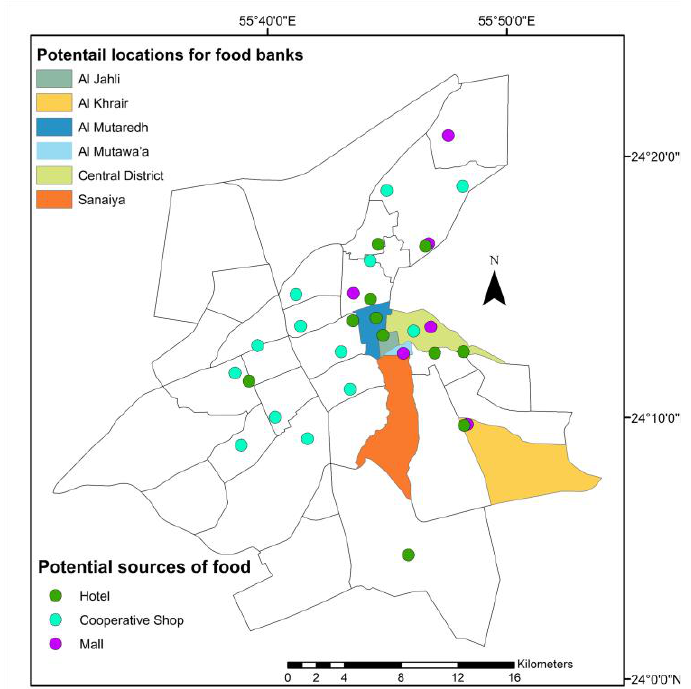
Figure 1. Potential districts for food banks.